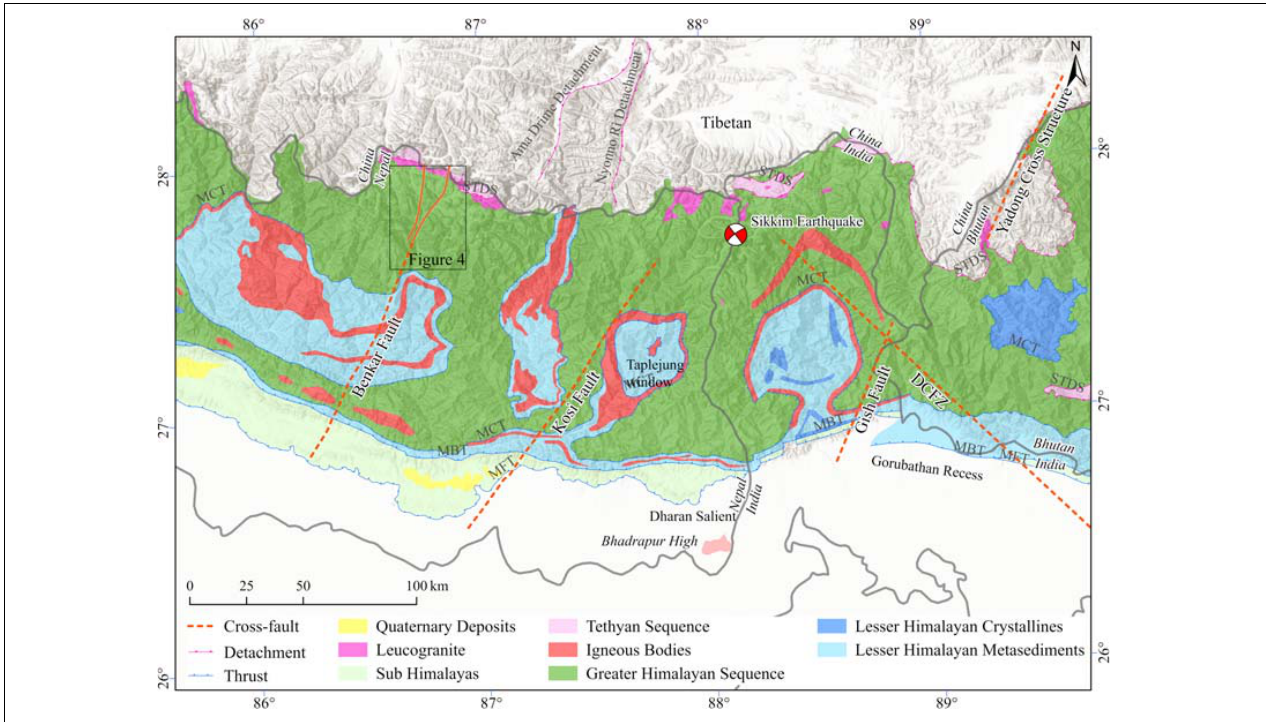
FIGURE 2 | Simplified geologic map of eastern Nepal, India, and western Bhutan. The red dashed lines are the approximate locations of the Benkar, Kosi, Gish, and Dhubri-Chungthang cross faults. The solid yellow lines are the bounds of the Benkar fault zone that have been mapped in the Greater Himalayan Sequence (Seifert, 2019). Sikkim M w 6.9, 2011 earthquake fault plane solution from Paul et al. (2015). DCFZ: Dhubri-Chungthang Fault Zone; MBT: Main Boundary Thrust; MCT: Main Central Thrust; MFT: Main Frontal Thrust; STDS: South Tibetan Detachment System; [Map data from the Department of Mines and Geology, Nepal, the Geological Survey of India, and Greenwood et al. (2016). Map compiled by Bibek